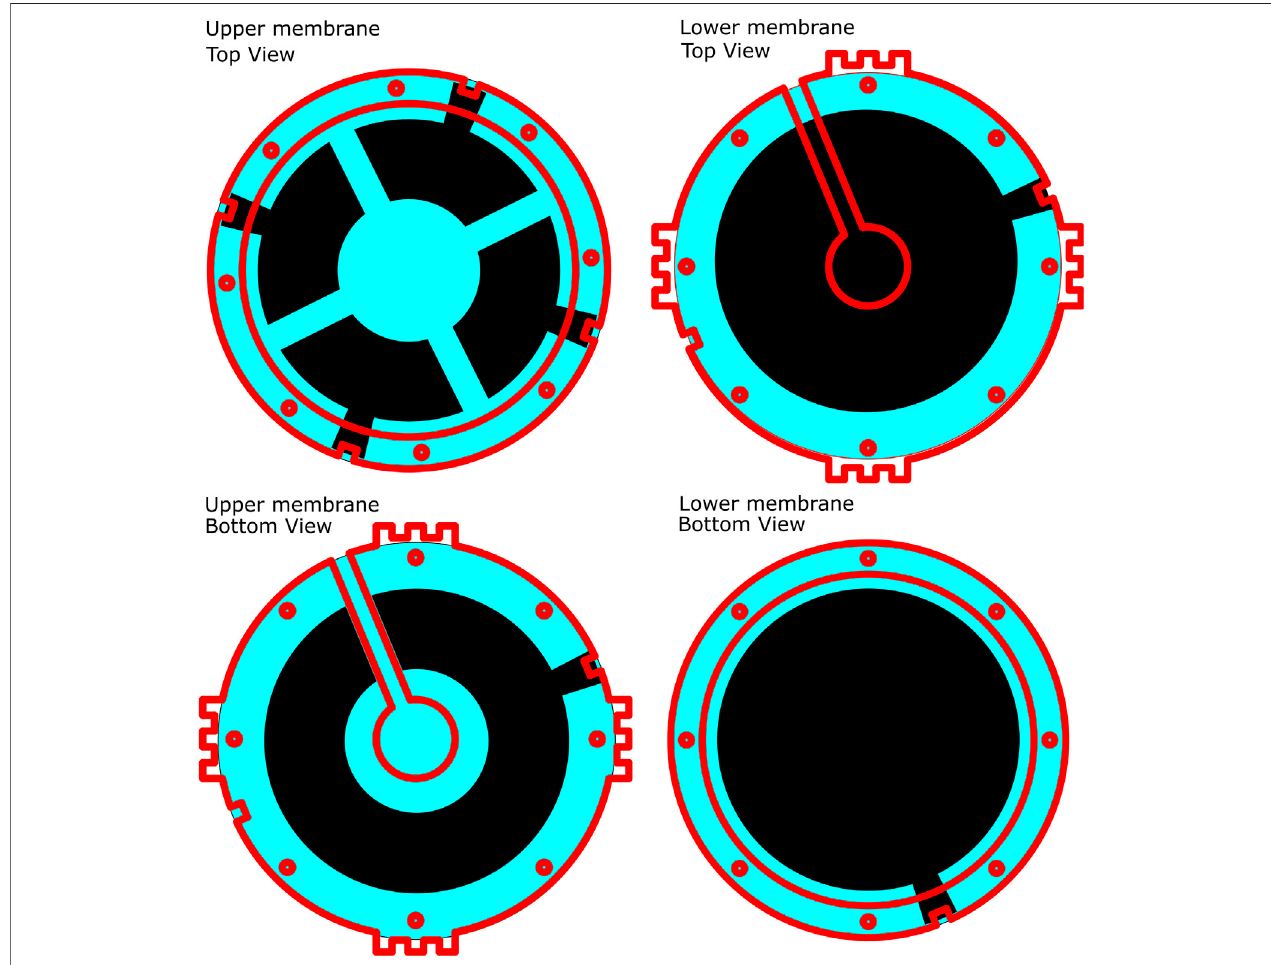
FIGURE 4 | Structure of the MIDA test setup in the de fl ated state, red lines indicate the position of the edges of acrylic support frames. Top Left: Top view, upper membrane. Top Right: Top view, lower membrane. Bottom Left: Bottom view, upper membrane. Bottom Right: Bottom view, lower membrane. Small holes show bolt placement, air channel visible on Top Right and Bottom